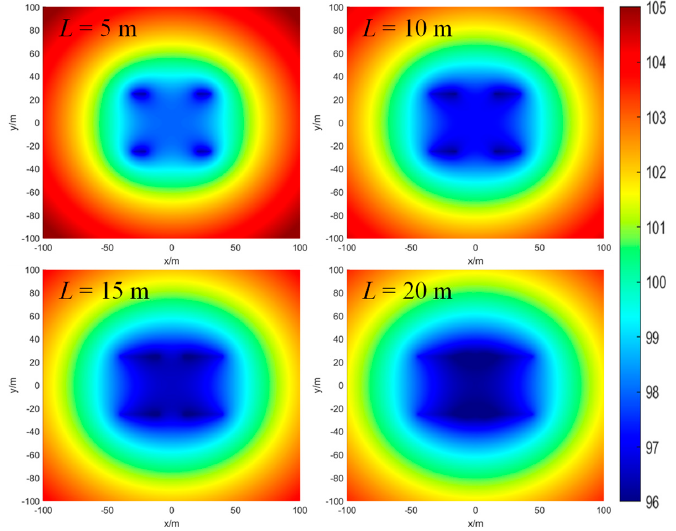
Figure 10. Distribution of pressure field of coal seam under homogeneous fracturing.